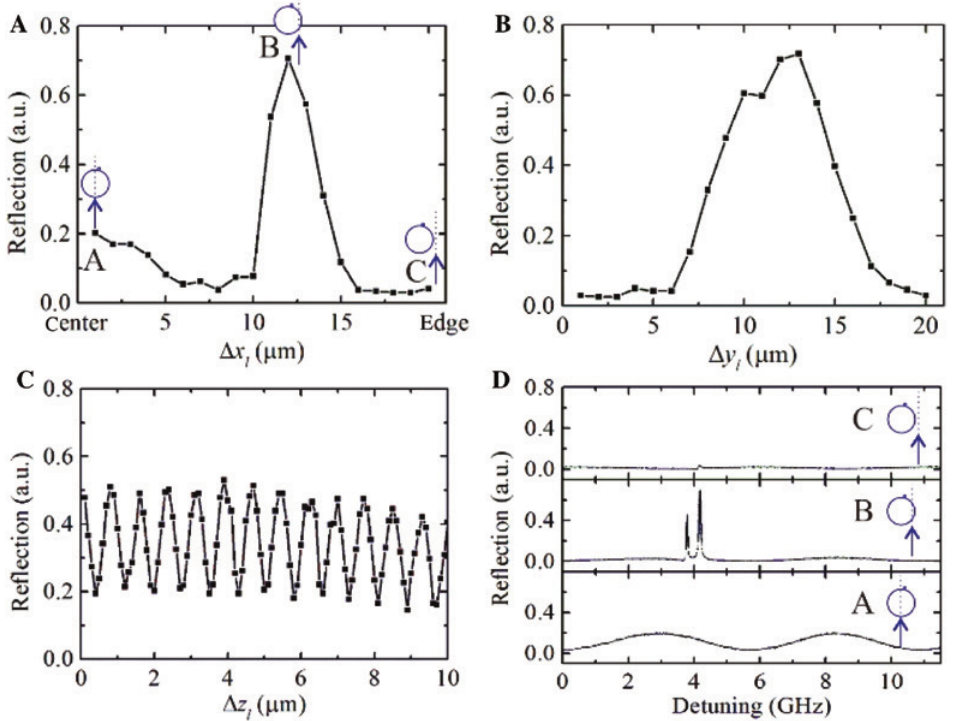
Figure 3: The amplitude of the reflection as a function of the spatial position of the GRIN lens (incident beam). Peaks in the reflection spectra vary with the relative position Δ x (A), Δ y (B), and Δ z (C) of the GRIN lens (incident beam) when keeping the l l l nanotip-sphere coupling system invariant. (D) Reflection spectra at three positions of Δ x . The letters A, B and C in (A) and (D) represent l three cases of relative position Δ x between the incident beam (arrows in the schematic diagram beside the letters) and the l